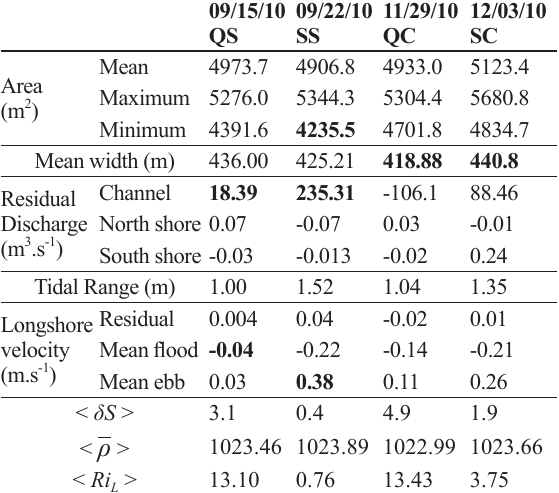
Values for each cycle. < δS > = salinity range between the surface and bottom; < ρ > = average density in the water column; < Ri L > = the average Layer Richardson number per cycle; QS = neap cycle during the dry season; = SS spring cycle in the dry